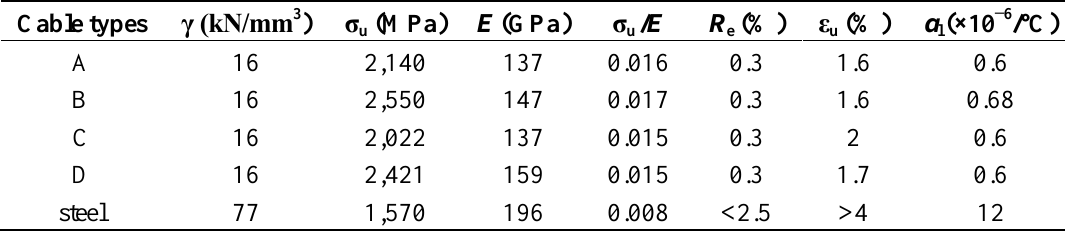
Table 1. Material properties of CFRP and steel